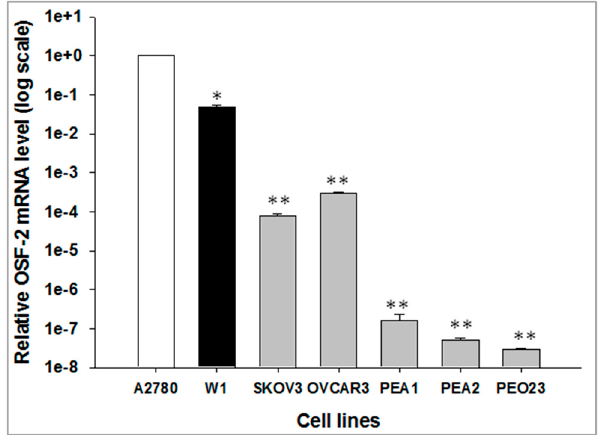
Figure 1. Expression analysis (Q-PCR) of the osteoblast-specific factor 2 (OSF-2) transcript in the different ovarian cancer cell lines. The figure presents the relative gene expression in cell lines (grey bars or black bar for W1) with respect to that in the A2780 cell line (white bar), which was assigned a value of 1. The values were considered significant at * p < 0.05 and ** p < 0.001, and are presented in log scale.